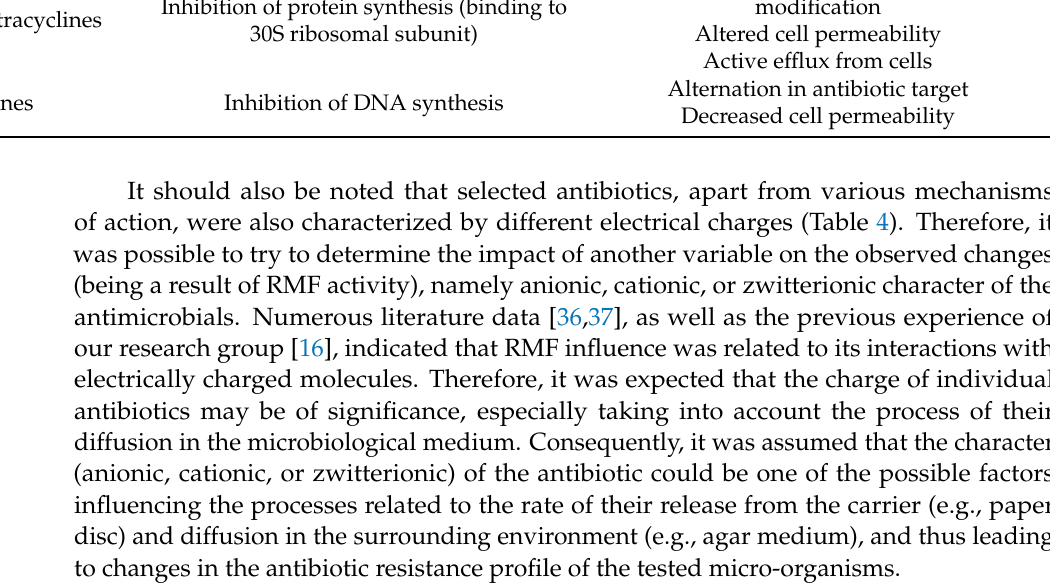
Table 3. Mode of action of antibiotic classes selected for the study and related resistance mechanisms [35]. Antibiotic Mode of Action Resistance Mechanism B-lactams, Glycopeptides Interference with cell wall synthesis Macrolides Inhibition of protein synthesis (binding to Lincosamides 50S ribosomal subunit) Inhibition of protein synthesis (binding to Aminoglycosides, Tetracyclines 30S ribosomal subunit) Fluoroquinolones Inhibition of DNA synthesis